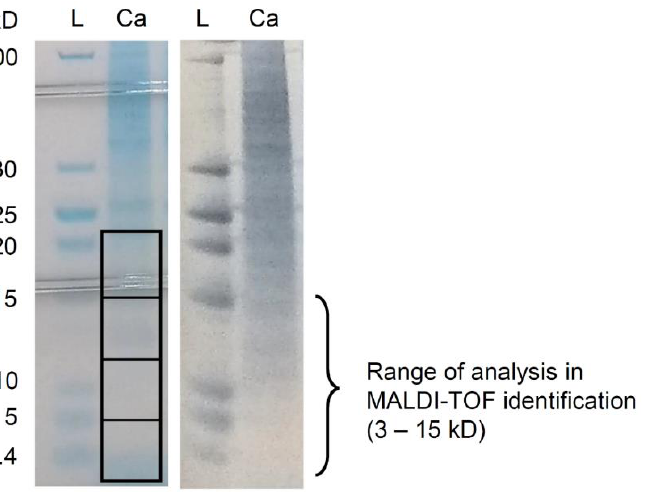
Figure 1. Example of 1D gel excision for proteomics. The material was extracted protein from Cutibacterium acnes subsp. acnes JCM 6425 T . Left: Coomasie blue staining with SimplyBlue Safe Stain (Thermo Fisher Scientific). Rectangles indicate excision areas (3–5, 5–12, 12–15, and 15–22 kD). Right: reverse staining with ExStain Reverse (Atto, Tokyo, Japan). L: lad- der. Ca: Cutibacterium acnes .